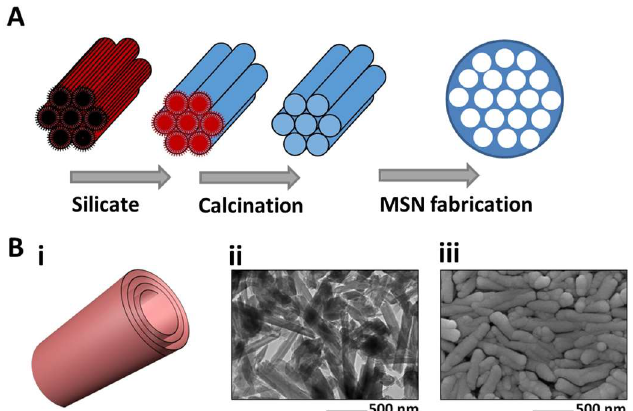
Figure 5. Oral delivery devices based on silica. ( A ) Fabrication of mesoporous silica nanoparticles (MSNs) (adapted with permission from [202]), ( B ) halloysite nanotube (HNT) microstructure (( i ) schematic representation of a HNT, ( ii ) transmission electron microscopy (TEM) image and ( iii )